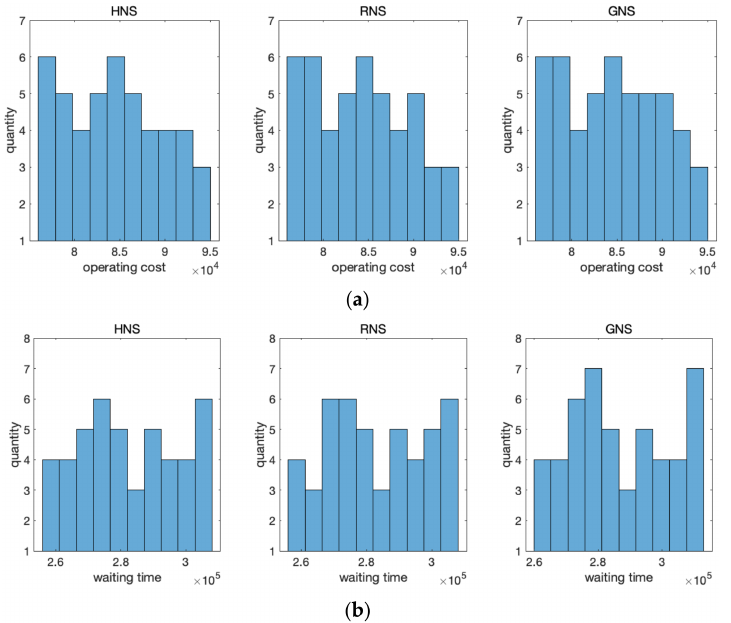
Figure 19. The histogram distribution of the solution sets’ operating costs and passenger waiting time. ( a ) The histogram distribution of operating cost; ( b ) the histogram distribution of waiting time.